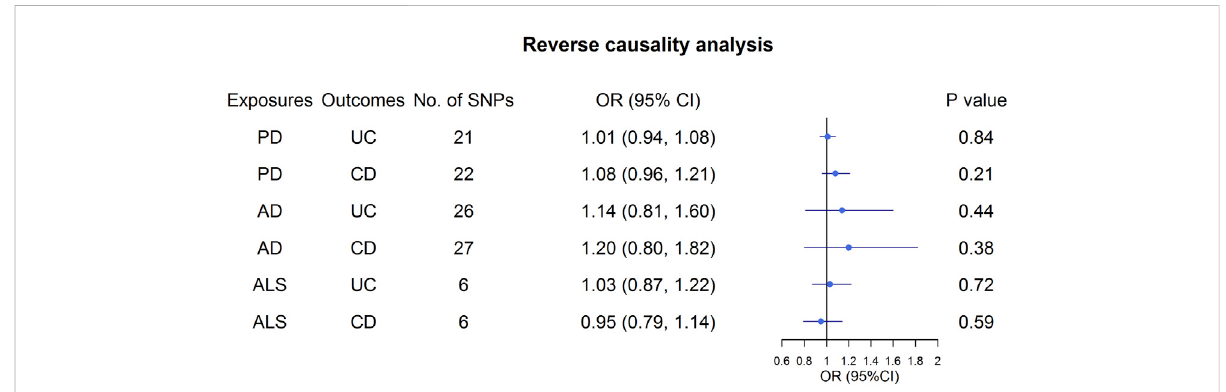
FIGURE 4 Effect estimates of NDs on UC and CD in the Mendelian randomization study. UC, ulcerative colitis; CD, Crohn ’ s disease; AD, Alzheimer ’ s Disease; PD, Parkinson ’ s Disease; ALS, Amyotrophic Lateral